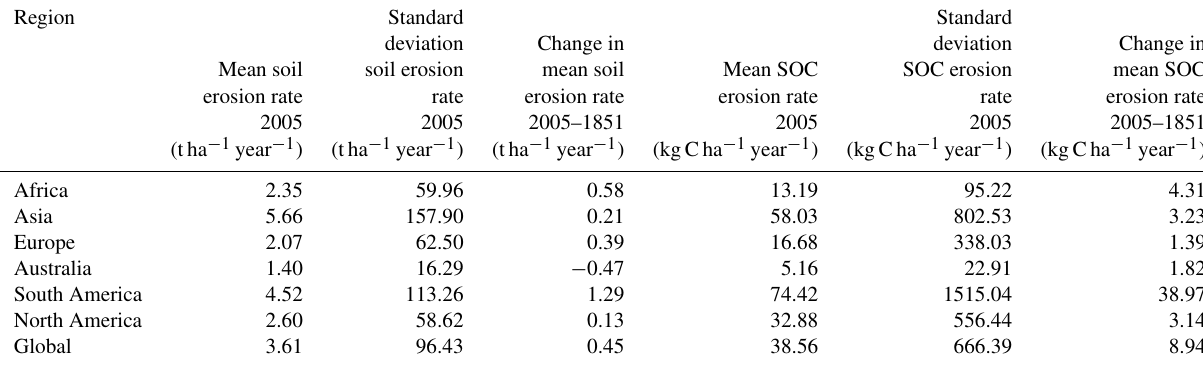
Table 3. Model estimates per continent of area-weighted average annual soil erosion and SOC erosion rates for the year 2005, their spatial standard deviations, and the changes in average soil and SOC erosion rates since 1851; the uncertainty range for soil and SOC erosion rates is 2%–36% and 3%–52%, respectively. The uncertainty range for the changes in soil and SOC erosion rates since 1851 is 3%–83% and 11%–166%,